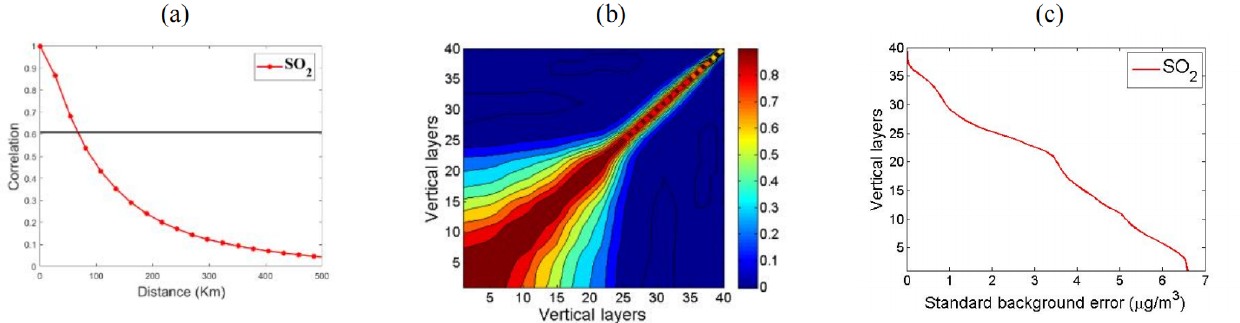
Figure 2. Background error covariation of SO 2 concentrations. (a) Vertical distribution of the horizontal correlation; the horizontal thin black line is the reference line ( e 1 / 2 ) used to determine the horizontal correlation scales. (b) Vertical correlations. (c) Vertical distribution of the standard deviation.